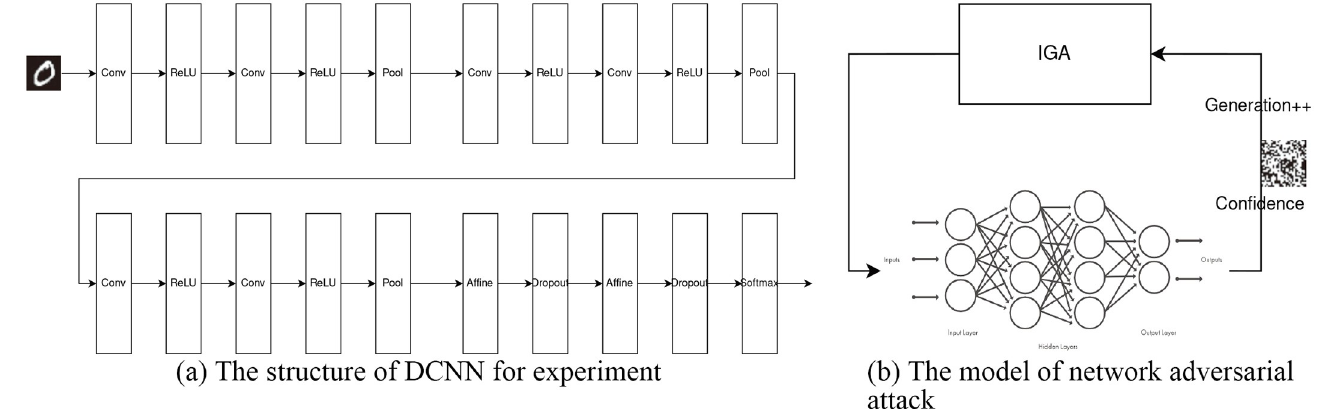
Fig 7. The model of network adversarial attack. (a) The structure of DCNN for experiment. (b) The model of network adversarial attack.